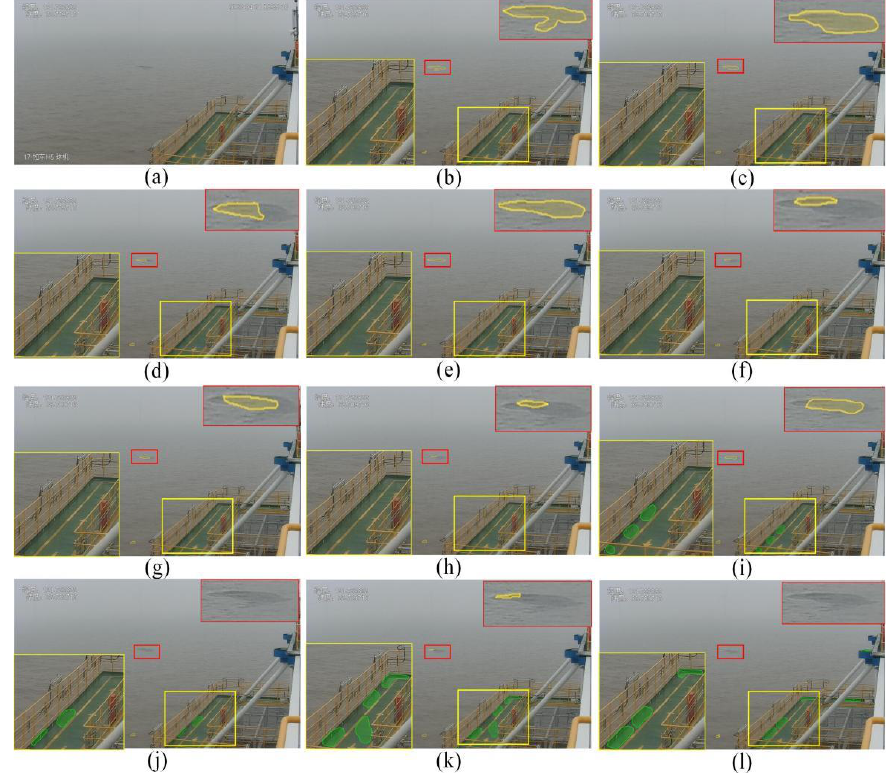
Figure 19. The visual comparison of results of different models in scene 6.